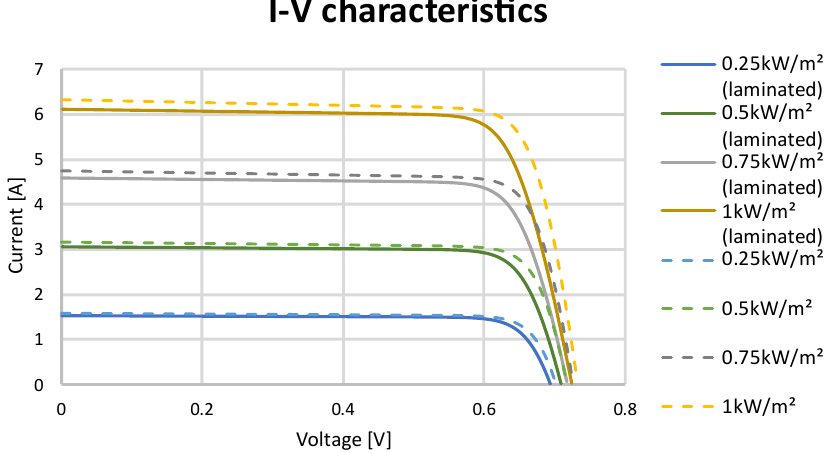
Figure 10. I–V curve at different irradiation levels for SunPower Maxeon Ne3 cells. Figure 10. I – V curve at different irradiation levels for SunPower Maxeon Ne3 cells.